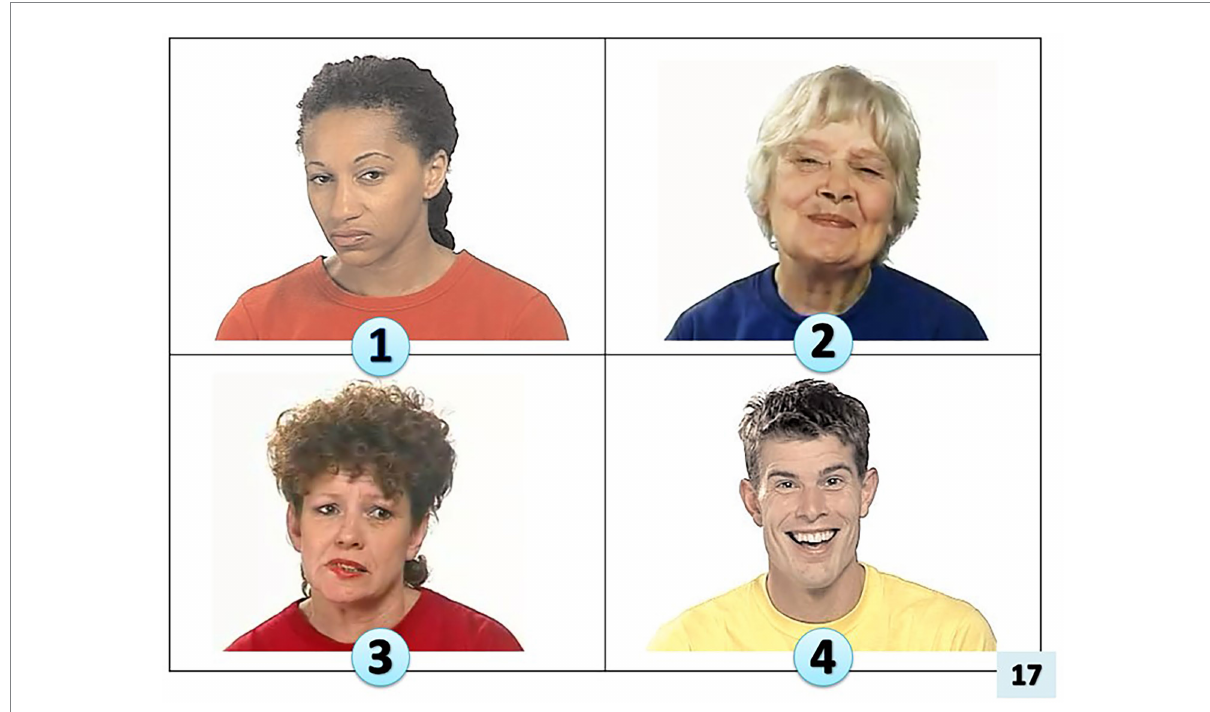
FIGURE 1 Picture stimuli for Receptive Emotion Vocabulary (REV) task (images, with the permission of The Autism Research Centre, The University of Cambridge; see footnote